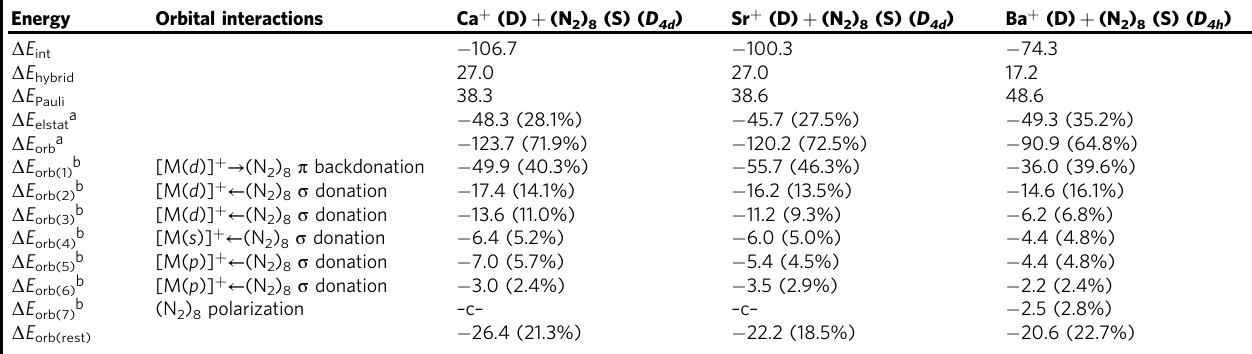
Table 4 EDA-NOCV results for doublet [M(N 2 ) 8 ] + (M = Ca, Sr, Ba) complexes at the M06-2X/TZ2P-ZORA//M06-2X-D3/ def2-TZVPP level Energy Orbital